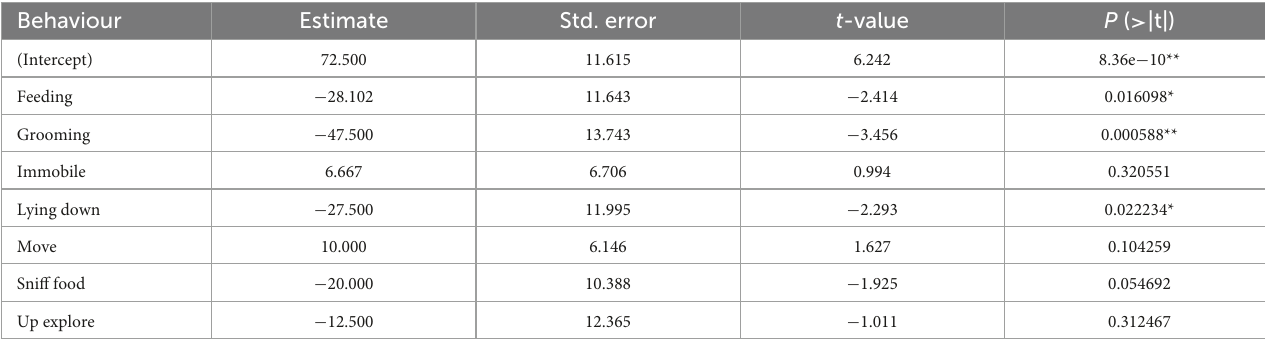
TABLE 2 Coefficients for the general linear model describing the frequency of USVs produced depending on the co-occurring behaviour (* p < 0.05, ** p < 0.001).